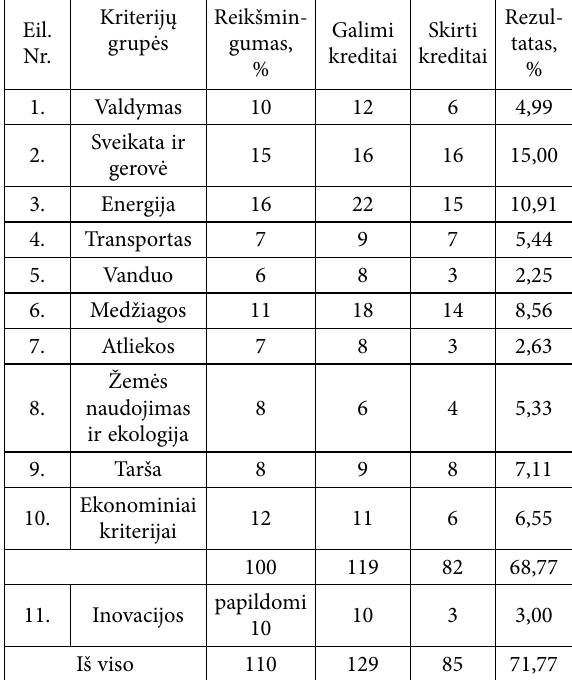
Table 4. The results of assessment a